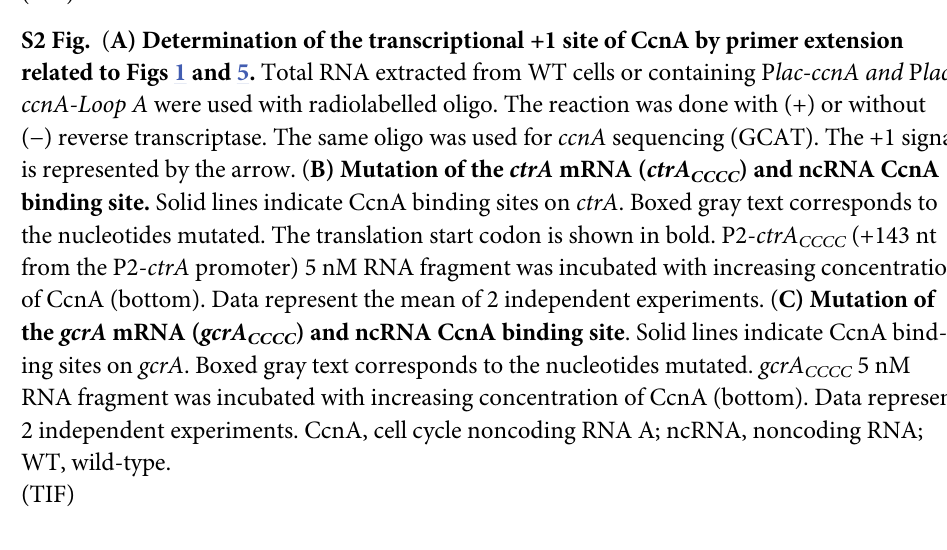
S6 Table. RNAseq Rockhopper data cited in S1A Fig. S7 Table. Raw data of growth curves cited in Figs 2, 6, S8, and S9. S8 Table. Raw data of cell length and width measurements obtained by MicrobeJ cited